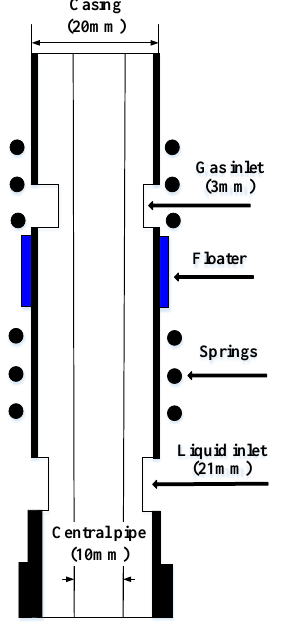
Figure 3. Gas – liquid separating valve schematic diagram.